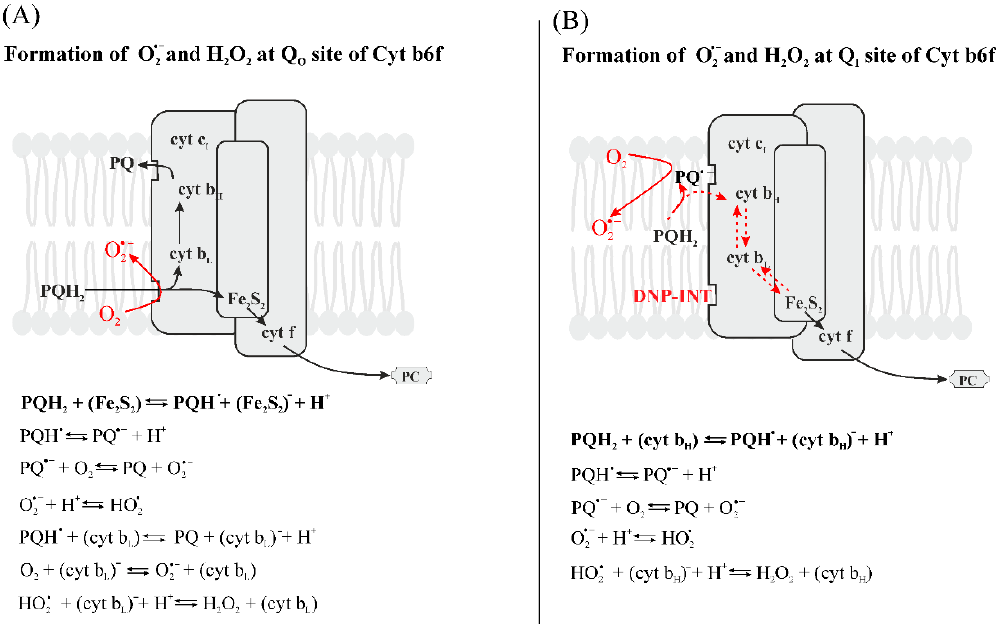
Figure 5. The proposed generation of O 2• − in Cyt b6f. ( A ) In the Q O site of Cyt b6f, PQH • is generated (Table 2) by the 2Fe-2S cluster of the high-potential Rieske iron − sulfur protein. PQ • − that has a long residence time within the Q O pocket, and cytochrome b L can also serve as a reductant for the